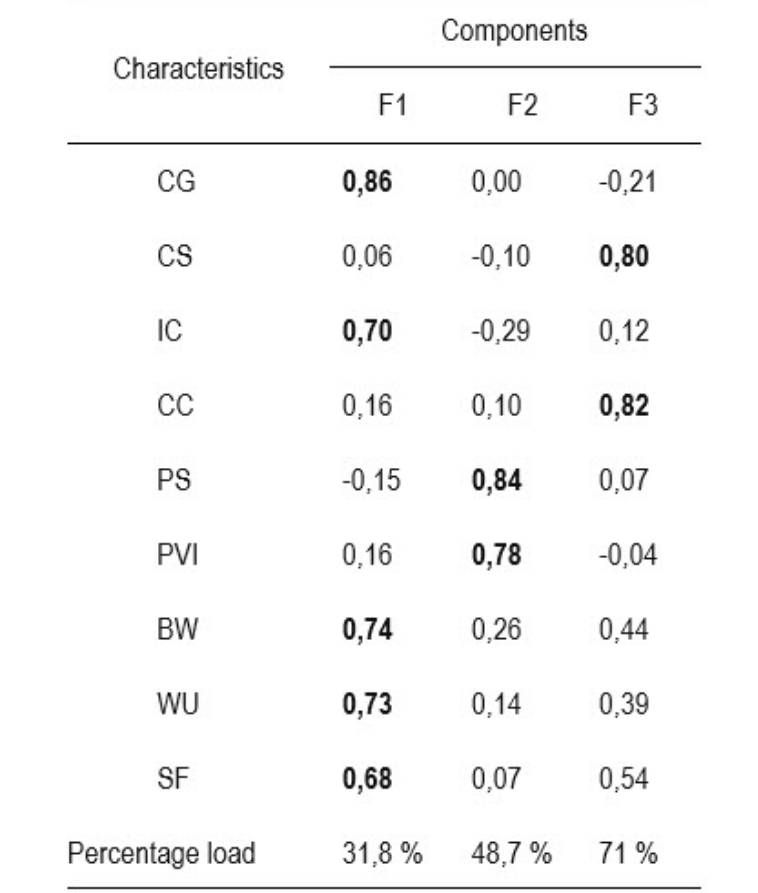
Factor structure of the students’ semantic, categoric and conceptual abilities indices coherence with their basic beliefs ones (group 3 - with mean (average)